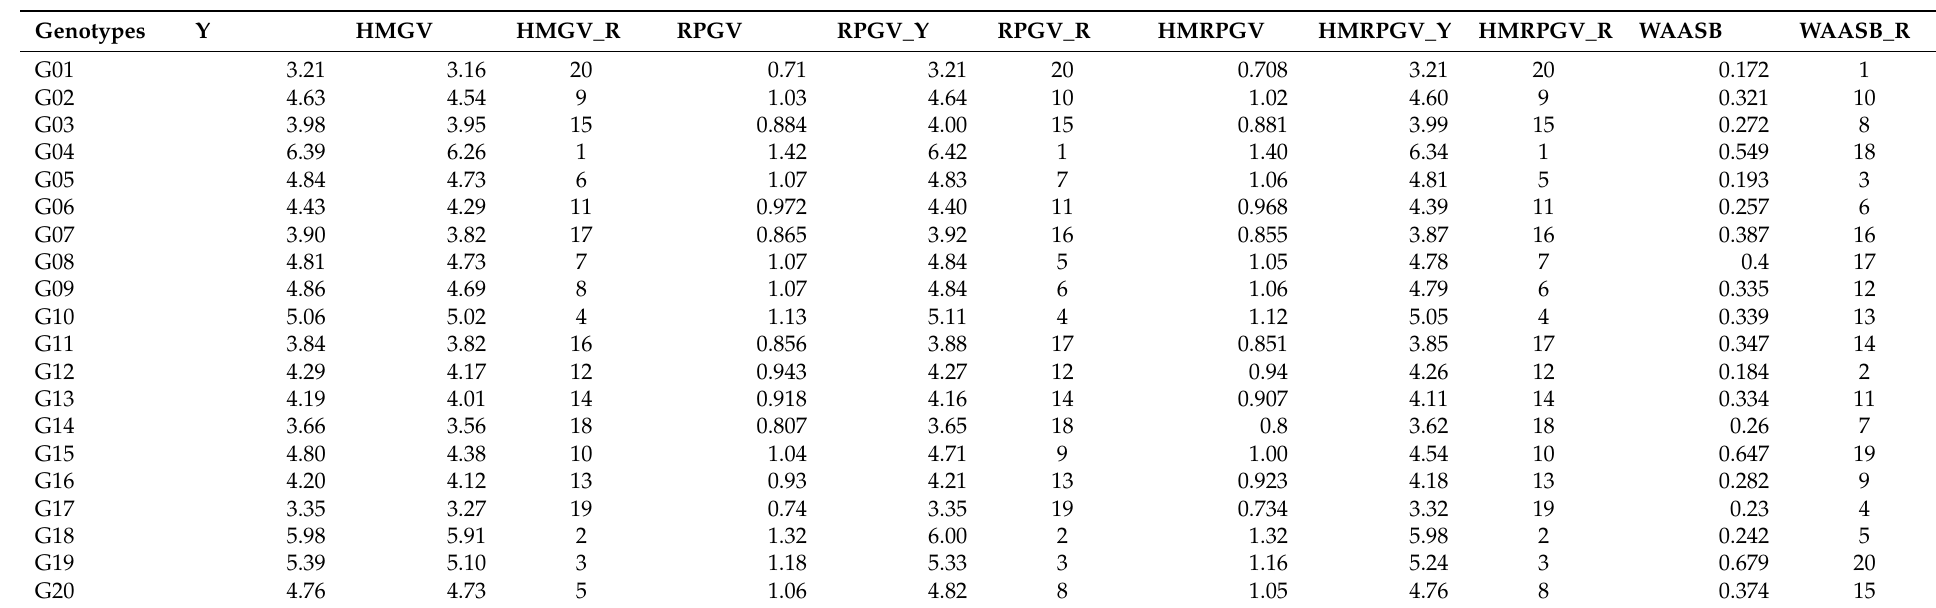
Table 7. Stability indexes based on a mixed-effect